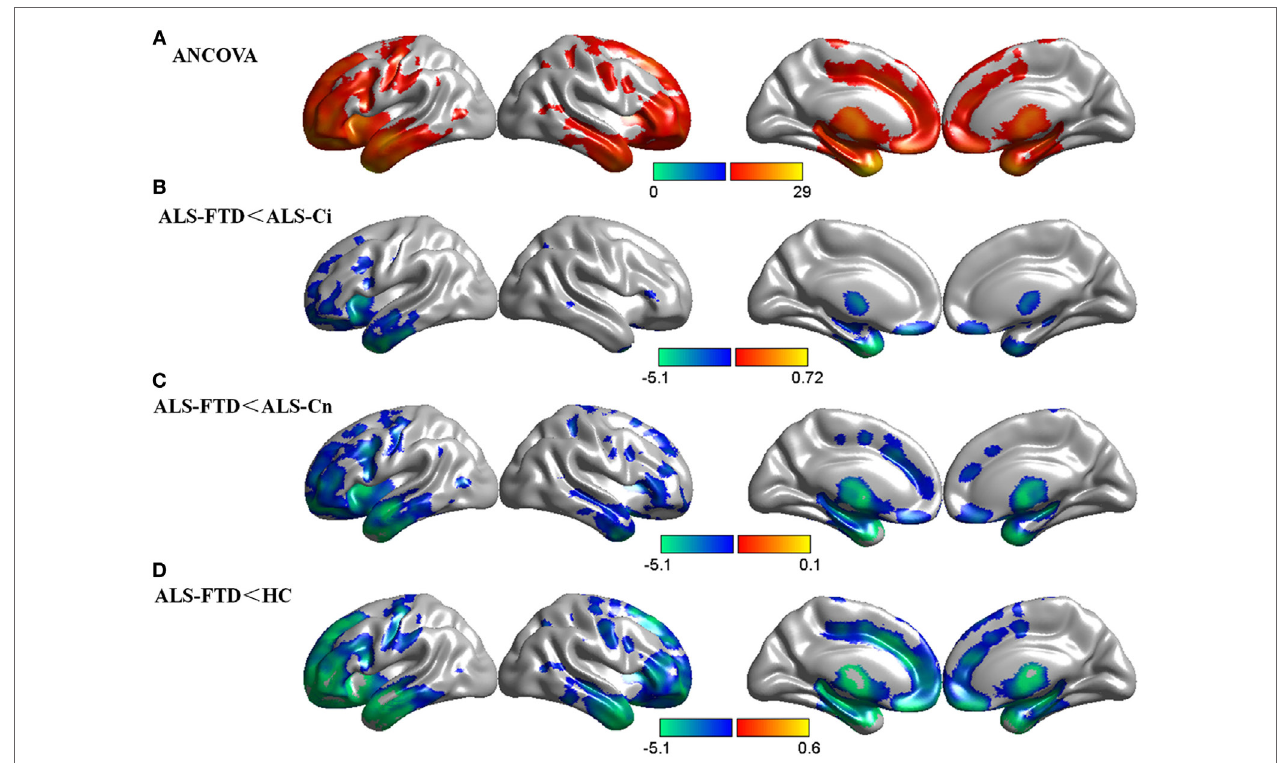
FigUre 1 | Group comparisons of gray matter (GM) data. (a) GM differences among the four subgroups. (B) GM reduction in amyotrophic lateral sclerosis (ALS)-frontotemporal dementia (FTD) patients compared with that in ALS with cognitive impairment (ALS-Ci) patients. (c) GM reduction in ALS-FTD patients compared with that in ALS with normal cognition (ALS-Cn) patients. (D) GM reduction in ALS-FTD patients compared with that in healthy controls (HCs). The color bar indicates the range of the F (a) or t (B–D) value. For all, p < 0.05 false discovery rate corrected. The results are visualized using Brant toolbox (version 2.0,